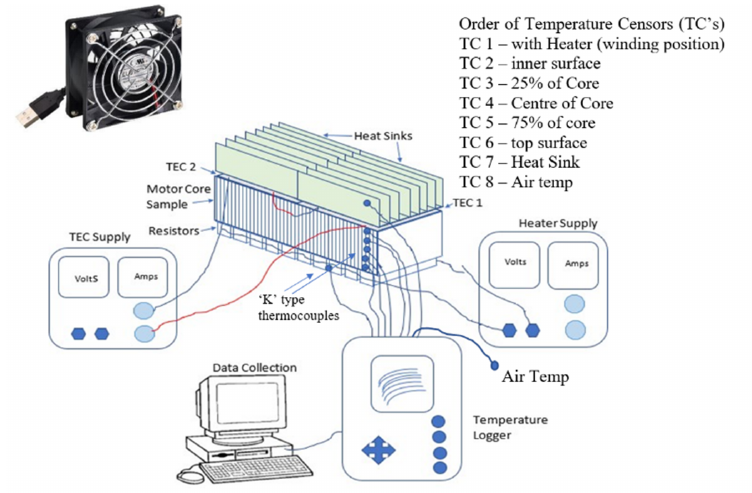
Figure 11. Experimental motor core sample setup.